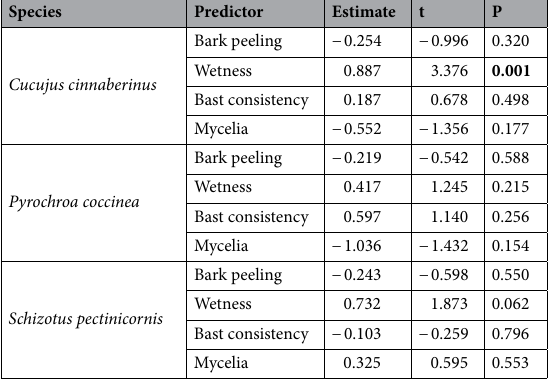
Table 2. Interactions of larvae of the three studied saproxylic beetles with the environment at the microhabitat level in the Pardubice Region (Czech Republic). GLM was used and significant P values are shown in bold.